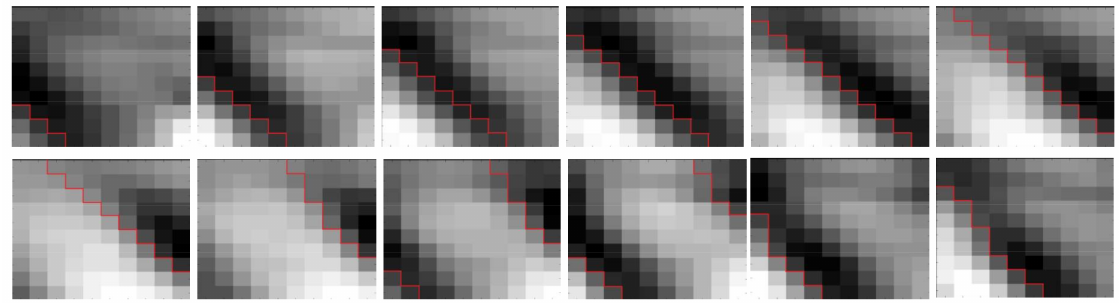
Figure 1. Intensity images of wind speeds (from left to right, top to